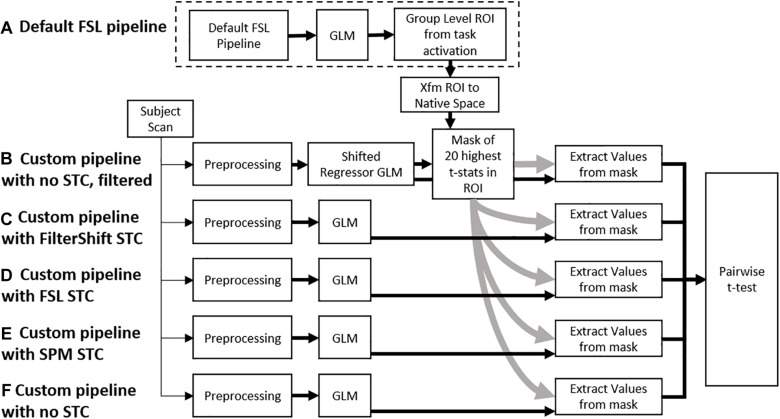
A flowchart of the processing pipeline for real data. (A) A default group level GLM is run on all subjects to obtain a region of activation, which is binarized into a mask and transformed back into each subject’s native space. This mask is used as an ROI to examine t-statistics from five different processing pipelines: (B) No STC, but the data is temporally lowpass filtered, and slice-dependent regressors shifted to account for the acquisition offset are used. (C) Our in house FS STC method is used. (D) FSL STC is used. (E) SPM STC is used. (F) No STC is used, and regressors are not shifted to account for slice offset. The statistics from pipeline b are used to identify 20 voxels with the highest t-statistics in the ROI. The standardized beta values from these 20 voxels are then extracted from the other pipelines, and the values are compared in a pairwise t-test.